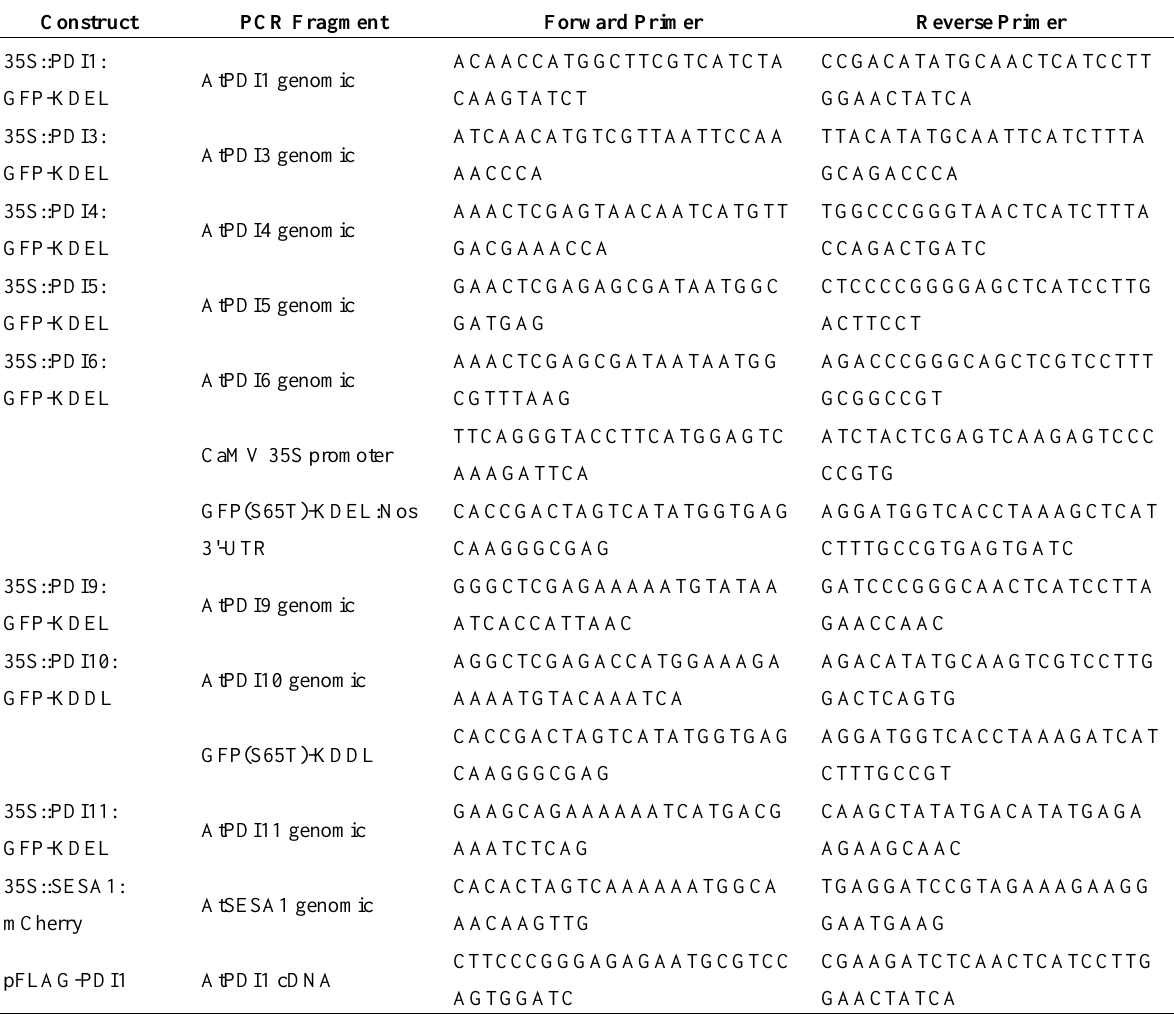
Table 2. List of